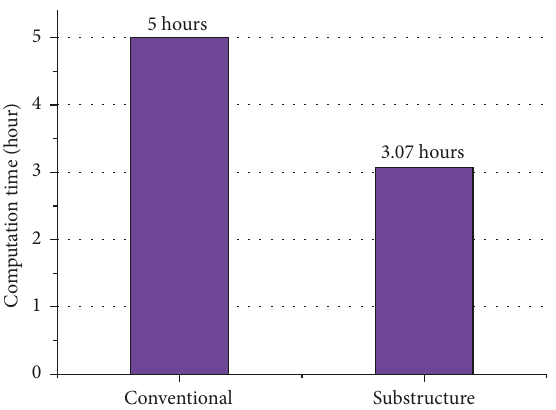
Figure 17: Optimization of body.